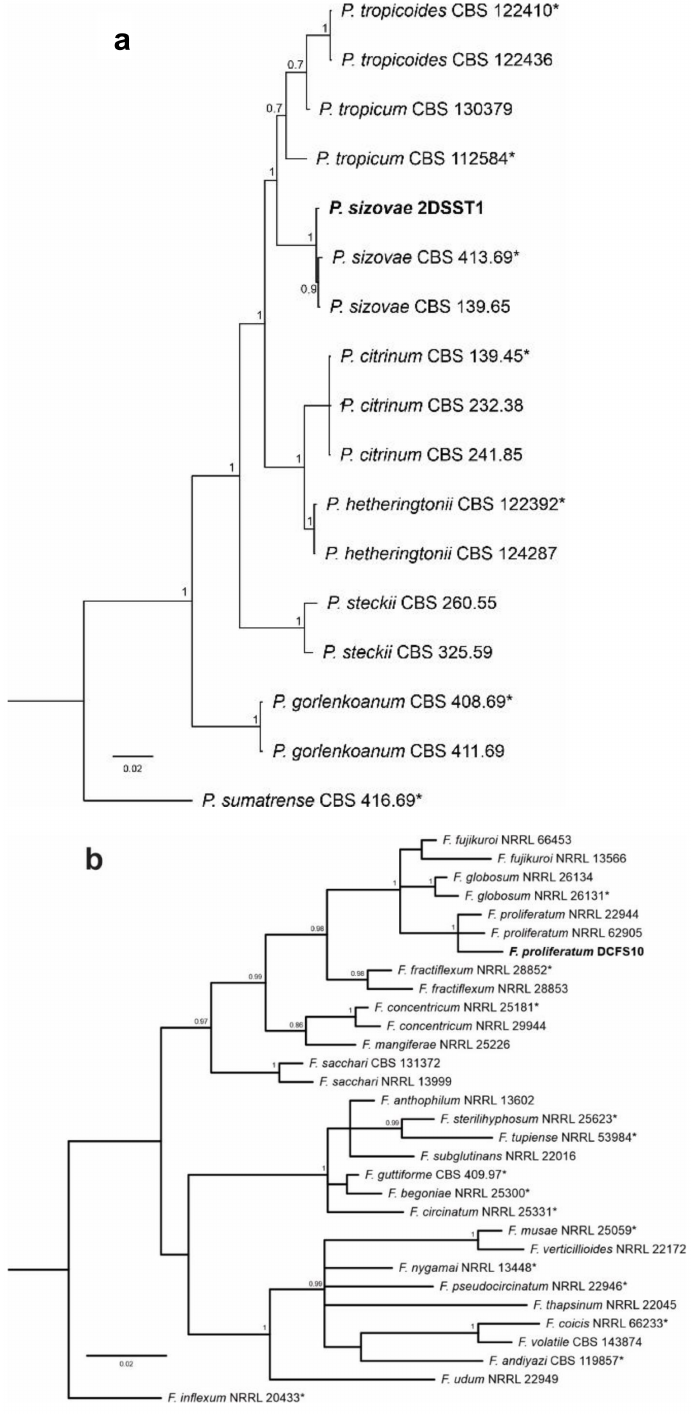
Figure 4. Bayesian phylogenetic tree based on concatenate sequences: ( a ) its , cam , tub2 , rpb 2 of Penicillium species section Citrina; ( b ) tub 2 and ef -1 α of the Fusarium fujikuroi species complex. Bayesian posterior probabilities are indicated at the nodes, and the scale bar represents the number of expected changes per site. Ex-type isolates are indicated with an asterisk (*), and the isolates reported here are highlighted in